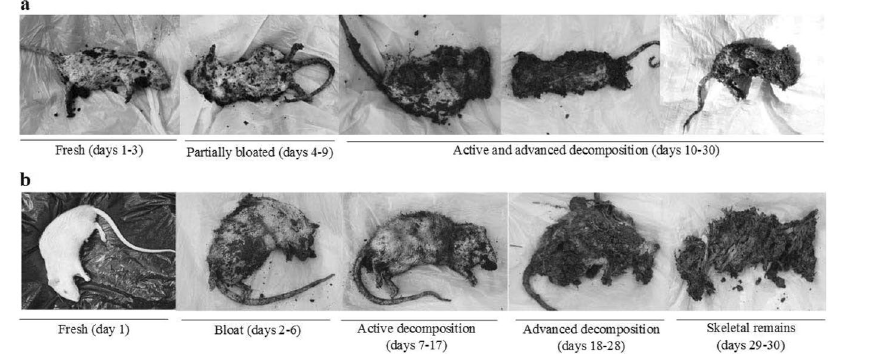
Figure 2. Decomposition stages of buried rat carcasses. ( a ) March; ( b )